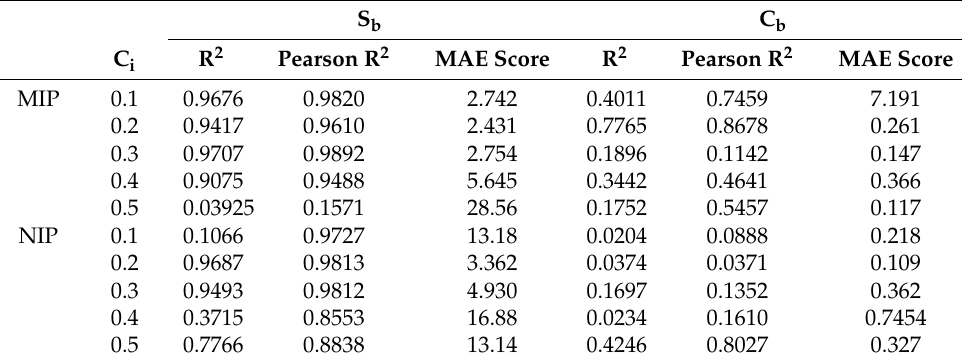
Table 7. Analysis of the error and correlation of the trained datasets at a given C i value for the graph convolution model with weave featurizer.